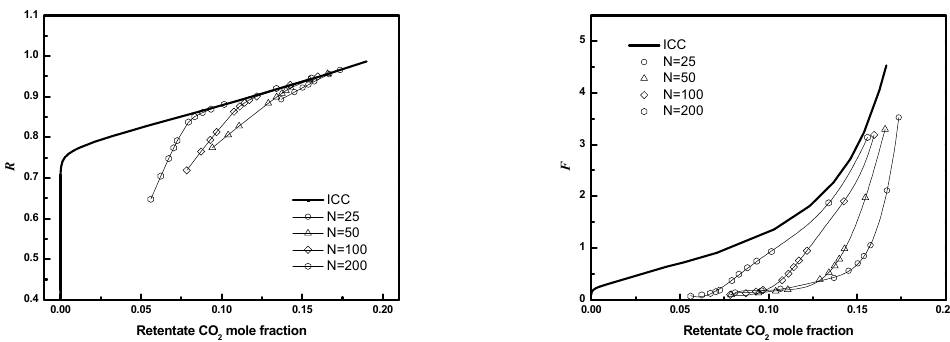
Figure 15. R or F as a function of CO 2 mole fraction for module with different fiber numbers (3-D) ( D/R f = 8, ɸ = 0 .4).